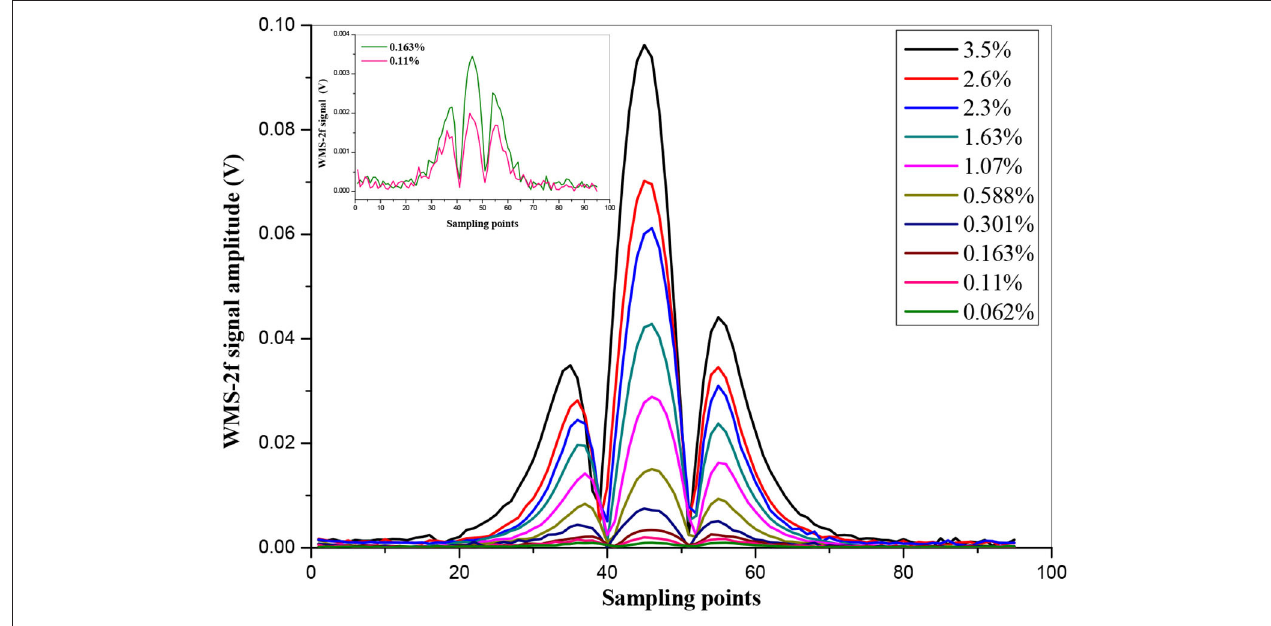
FIGURE 5 | WMS-2 f spectra recorded with different CH 4 gas concentration.